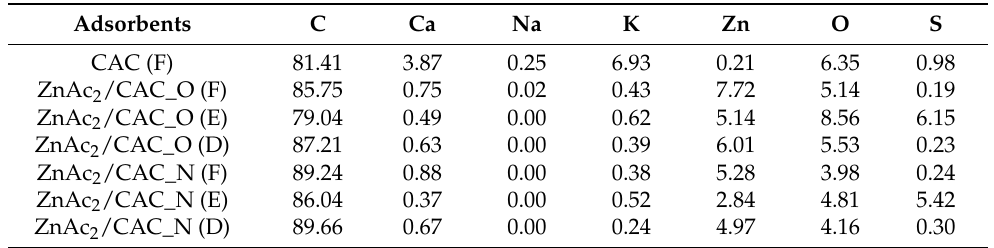
Table 10. Semi-quantitative chemical analysis of selected points in weight percent through EDX